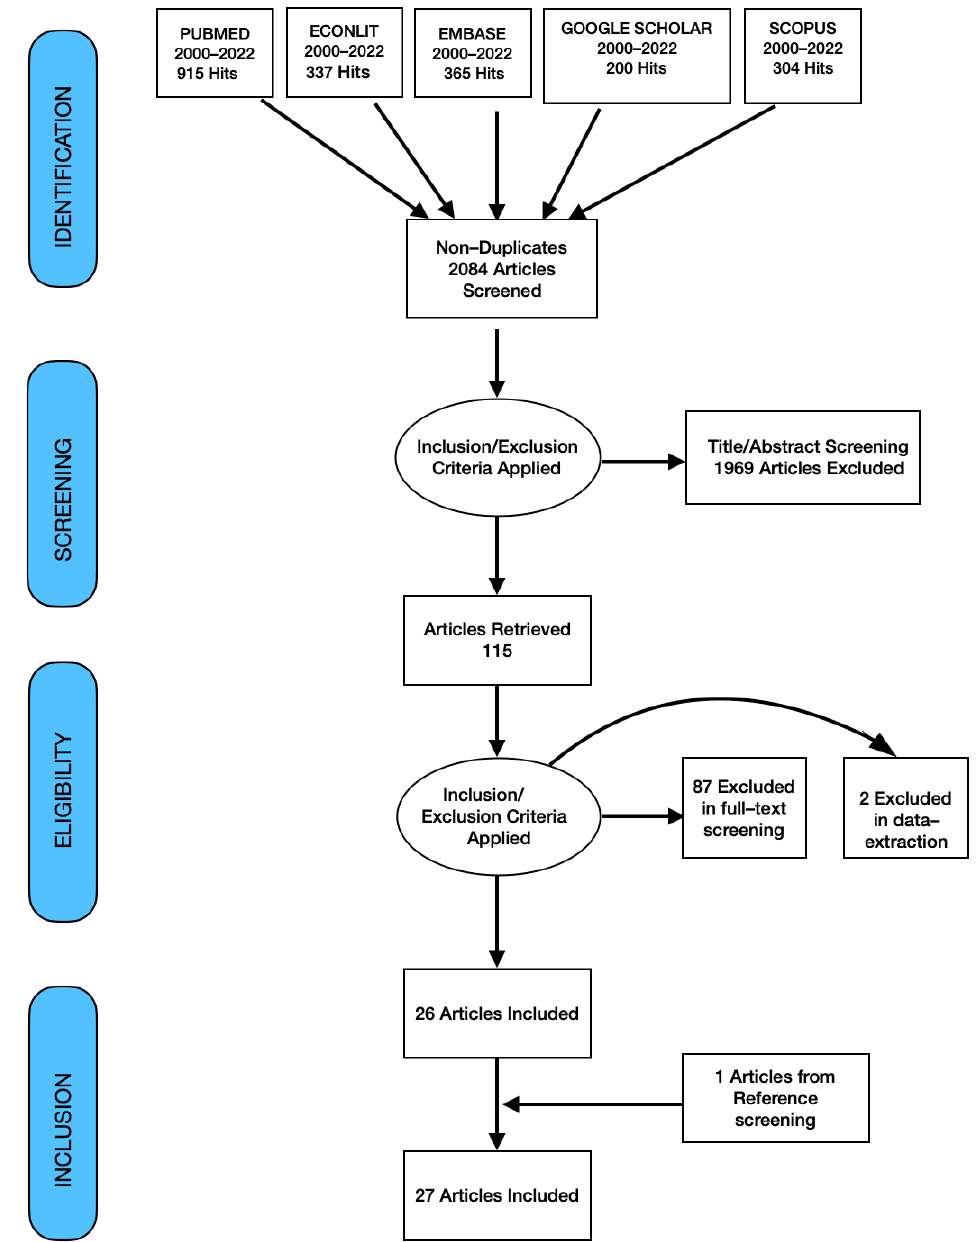
Figure 1. PRISMA flow chart of search, inclusion and exclusion screening and accepted studies of the review. Source: